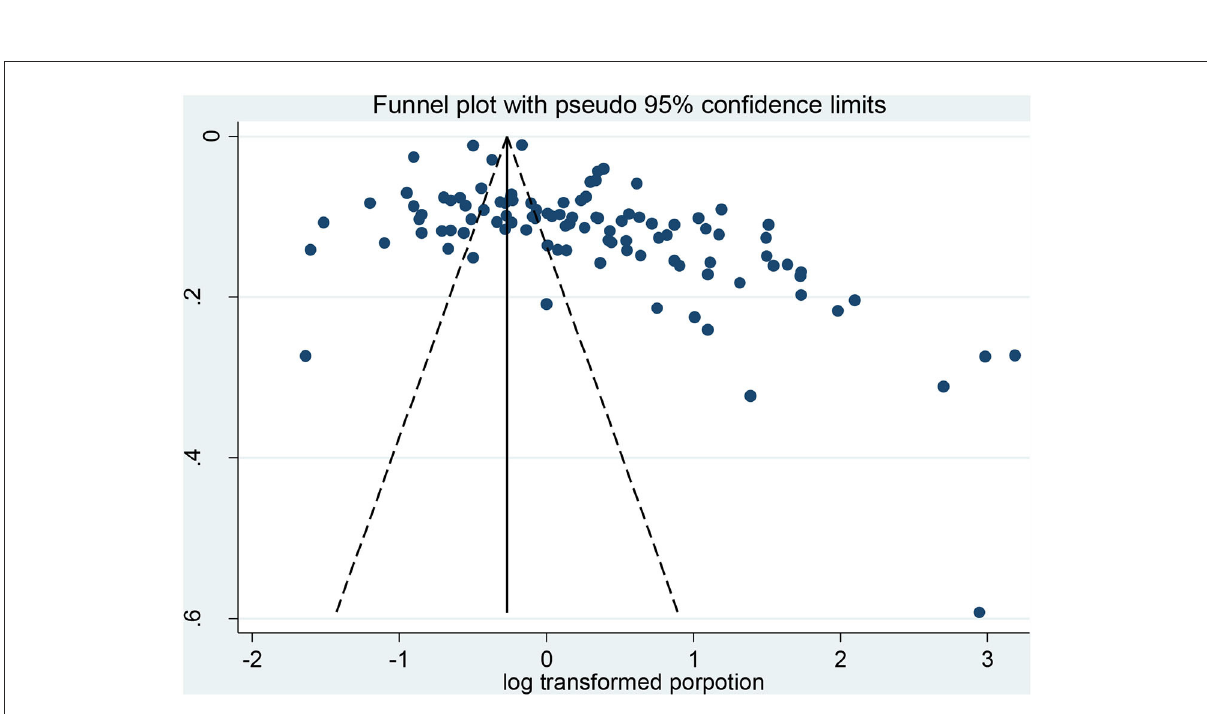
FIGURE4 Funnel plot of included